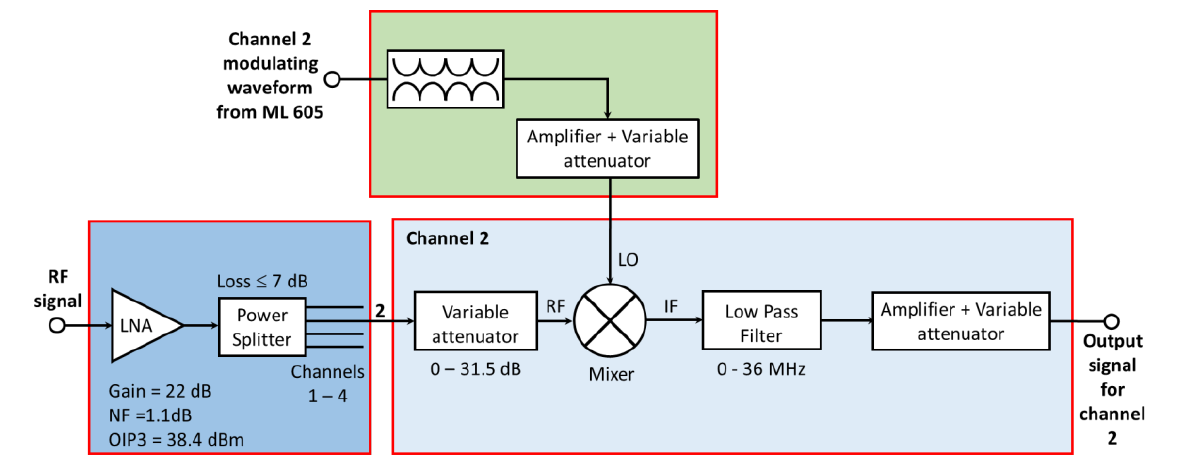
Figure 8. Photo of our analog front-end board.